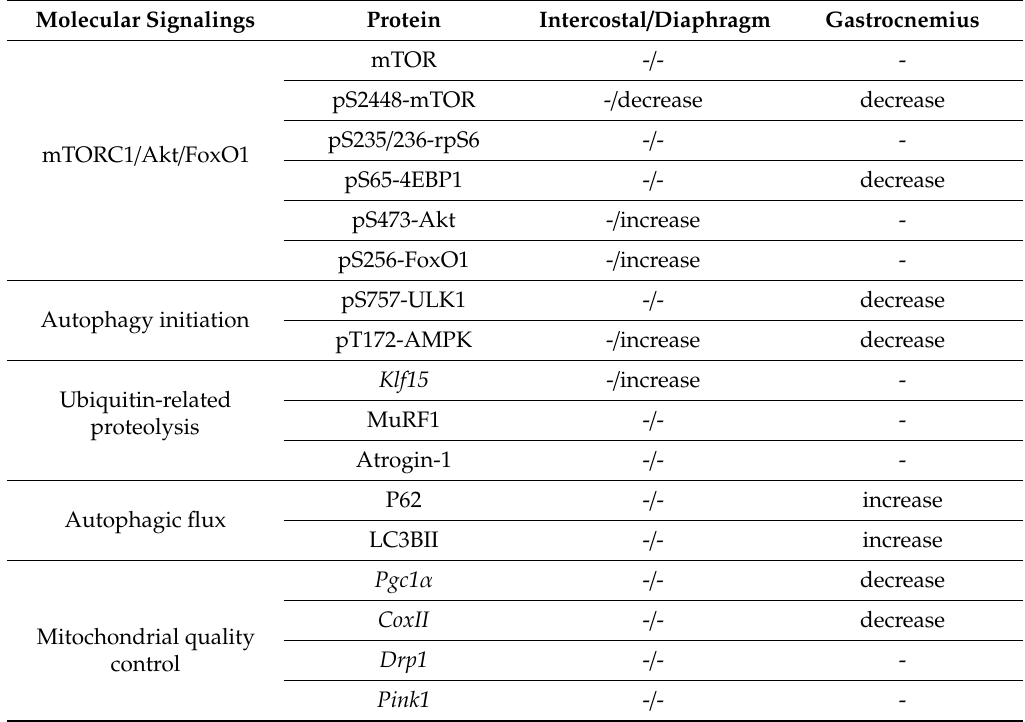
Table 1. Di ff erential changes of various signaling signatures in the aged respiratory and gastrocnemius